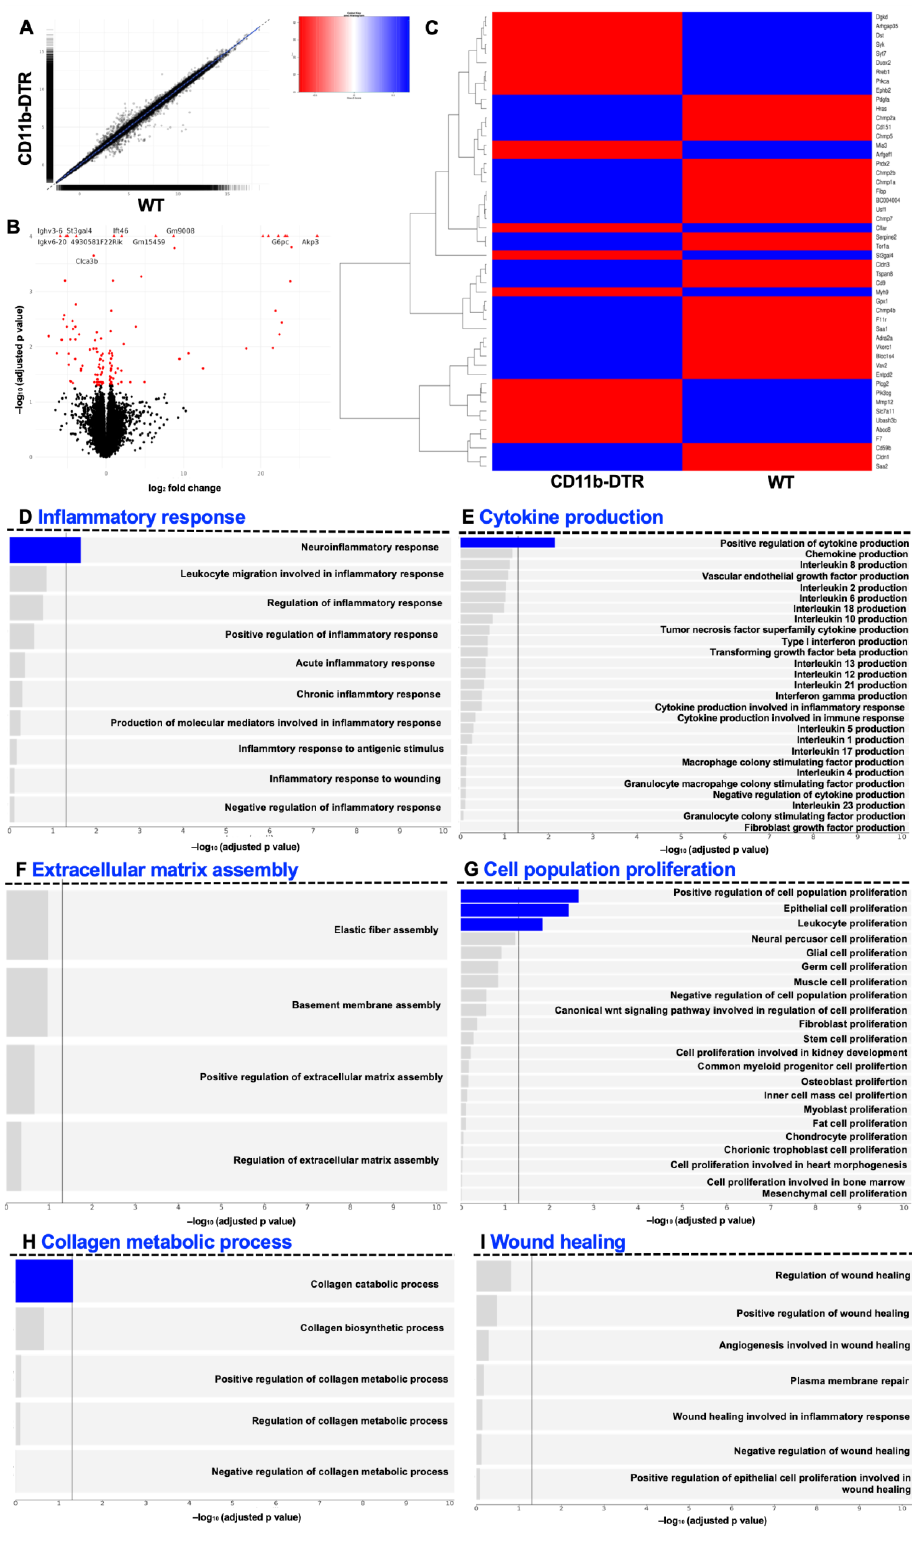
Figure 7. Gene set enrichment analysis of intestinal anastomotic healing during the proliferative phase. Gene set enrichment analysis (GSEA) results of anastomotic healing (AH) comparing wild type (WT) with CD11b-diphtheria toxin receptor (DTR) mice. RNA-Seq was performed on samples collected at postoperative day 9. Scatterplot ( A ) and volcano plot ( B ). Volcano plot showing